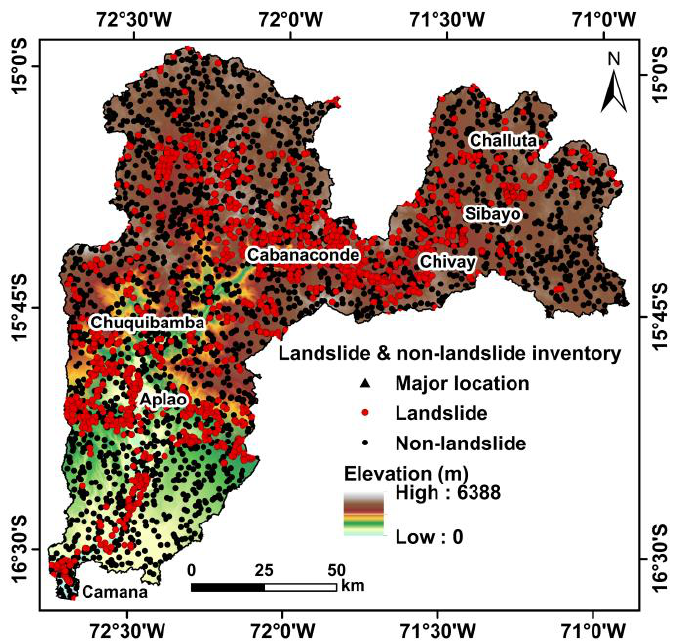
Figure 4. Spatial distribution of landslide and non-landslide locations wrapped over a DEM of the study area.